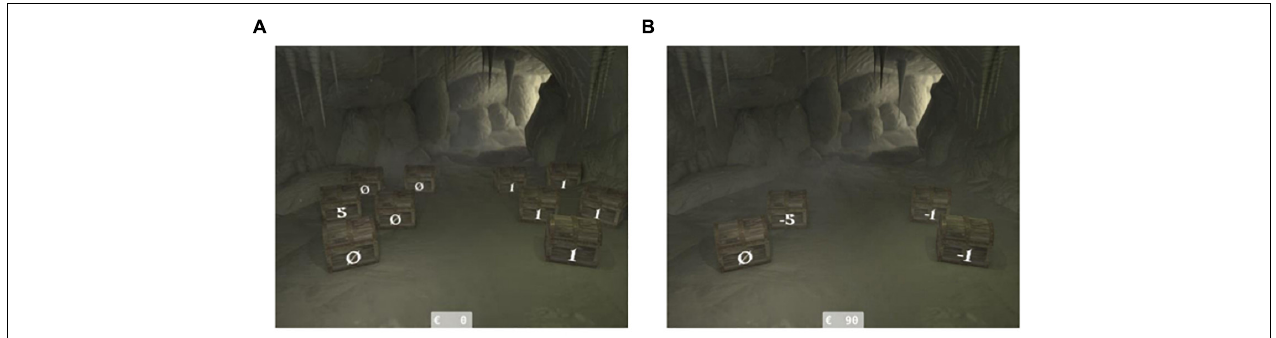
FIGURE 1 | Illustration of the THT for the two valence domains, THT Gain (A) and THT Loss (B) , in which participants had to choose between a safe side (outcome is always the same) and a gamble between a high gain/loss or nothing, while all outcome probabilities are calculable.